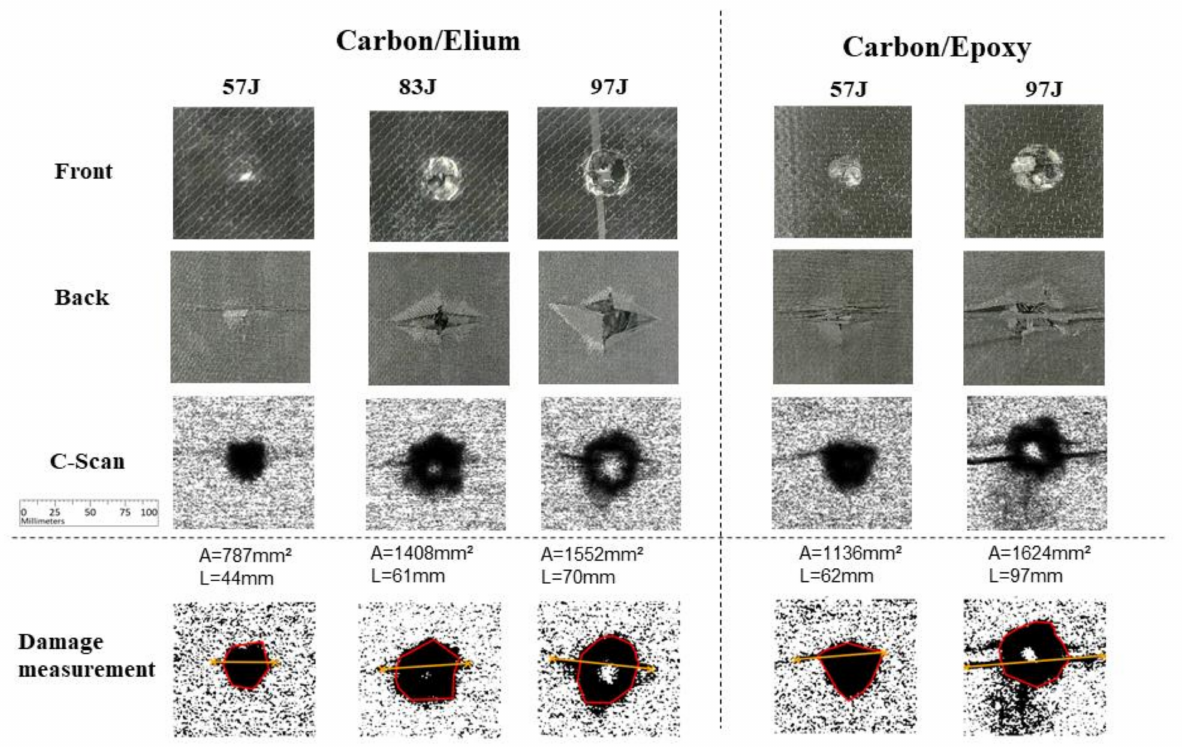
Figure 13. Experimental results for Carbon fiber